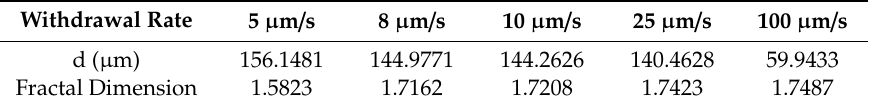
Table 2. Geometrical characteristics of the primary phase at di ff erent withdrawal